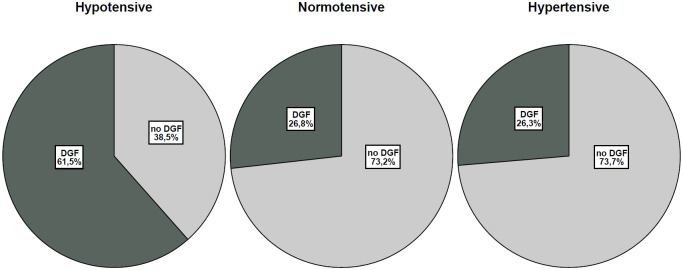
DGF incidence in the hypotensive, normotensive, and hypertensive group.DGF incidence was higher in the hypotensive group vs. normotensive and hypertensive groups (p<0.001).